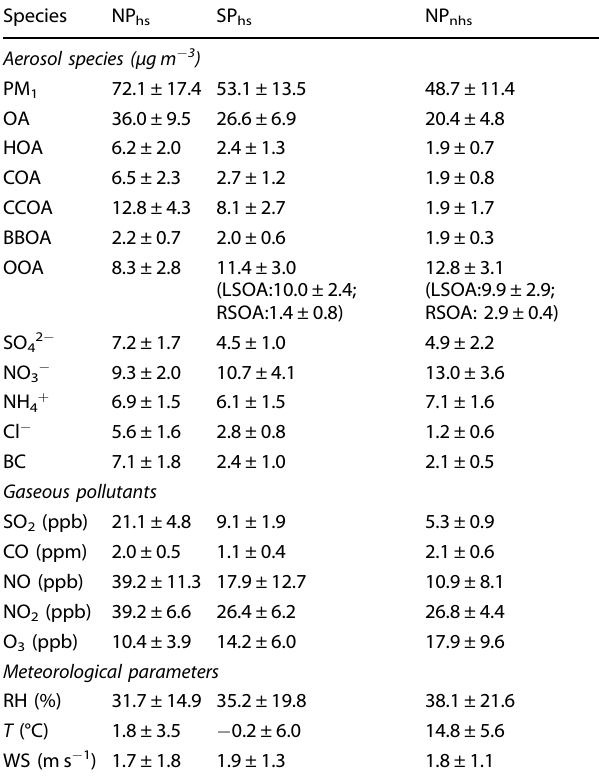
Fig. 3 Comparisons of OA factors between deweathered and observed results. a Mass concentrations and b fractions of deweathered and observed OA factors during the NP hs , SP hs and NP nhs . The observed and deweathered change ratios of OA factors between c NP hs and SP hs , d SP hs and NP nhs (The bars below the horizontal line represent increased ratios and the bars above the horizontal line represent decreased ratios of OA factors). Table 2. Deweathered mass concentrations (averages + standard deviations) of aerosol species and OA factors, gaseous pollutants, and meteorological parameters during three different